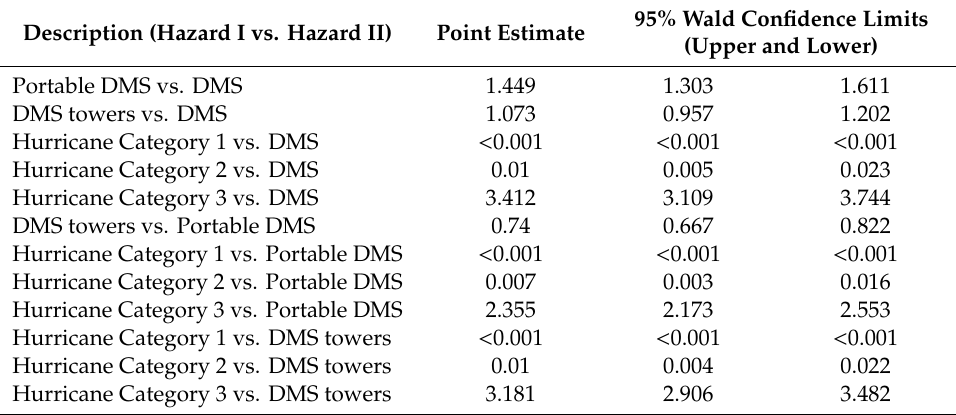
Figure 7. Cumulative incidence function estimates for dynamic message sign components compared with hurricane failure intensities. Table 2. Pairwise: hazard ratios for failure (DMS components).